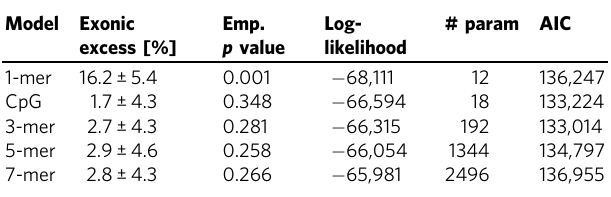
Table 2 Extended sequence context dependency for Goldmann et al. 29